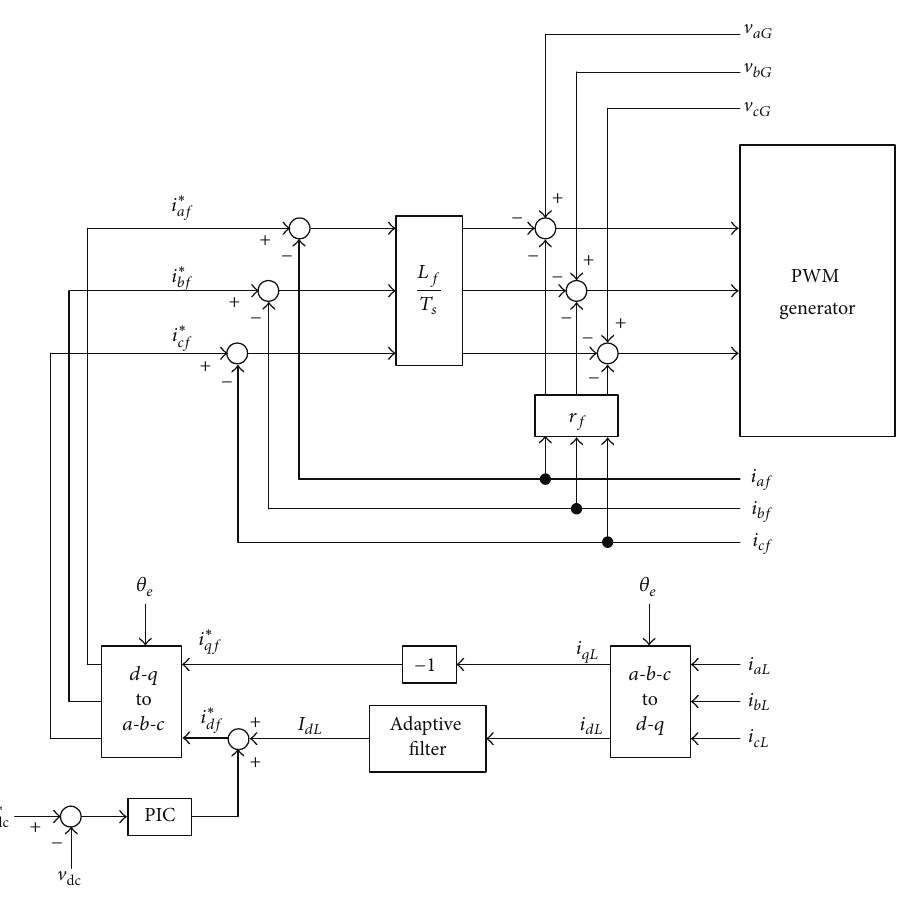
Figure 3: Control block diagram of 𝑑 - 𝑞 current controllers of the active power filter.